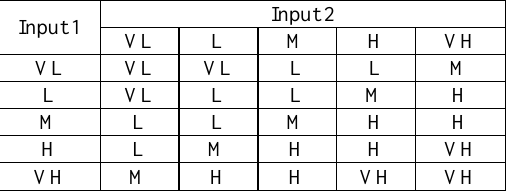
Table 1: Rule table and fusion rules used in fuzzy logic for five membership Gaussian functions ( Swathi et al., 2013 )